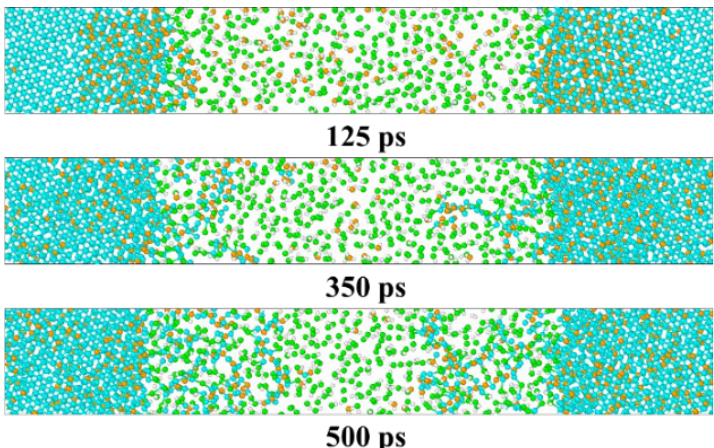
Figure 9. Temporal variations of model C. (Green is chlorine, white is hydrogen, aqua is iron and yellow is